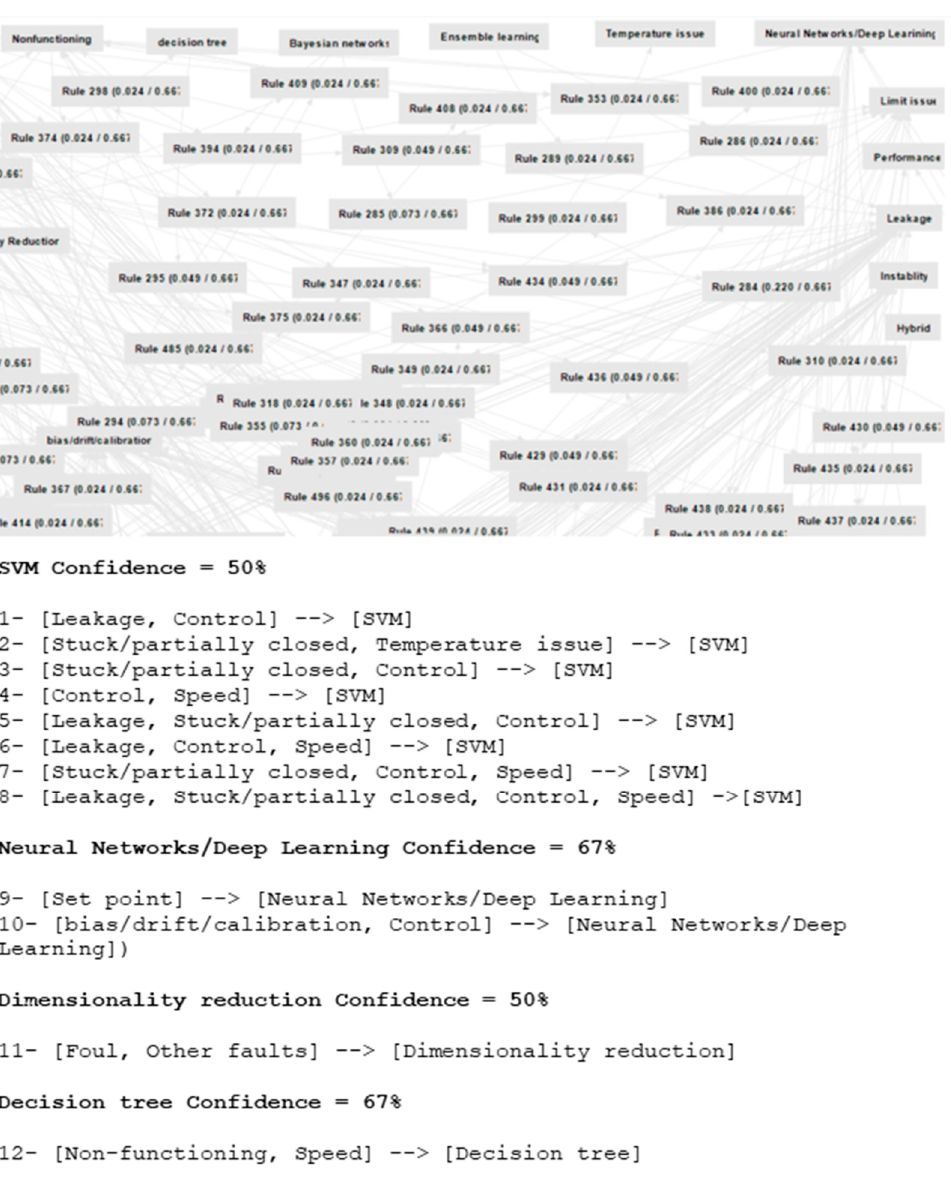
Figure 8. Excerpt of a deductive self-organizing graph (ISOM) for rules generated for techniques used for different HVAC fault types (minimum support = 2%).